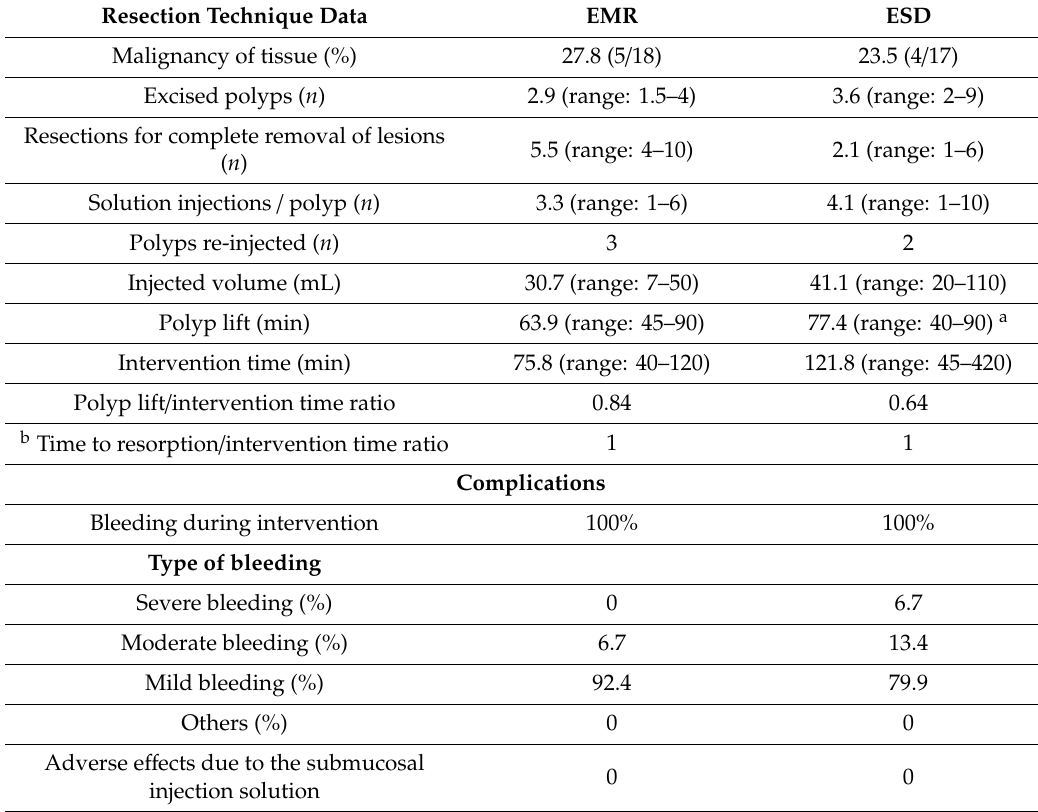
Table 3. Resection technique data and complications of intervention